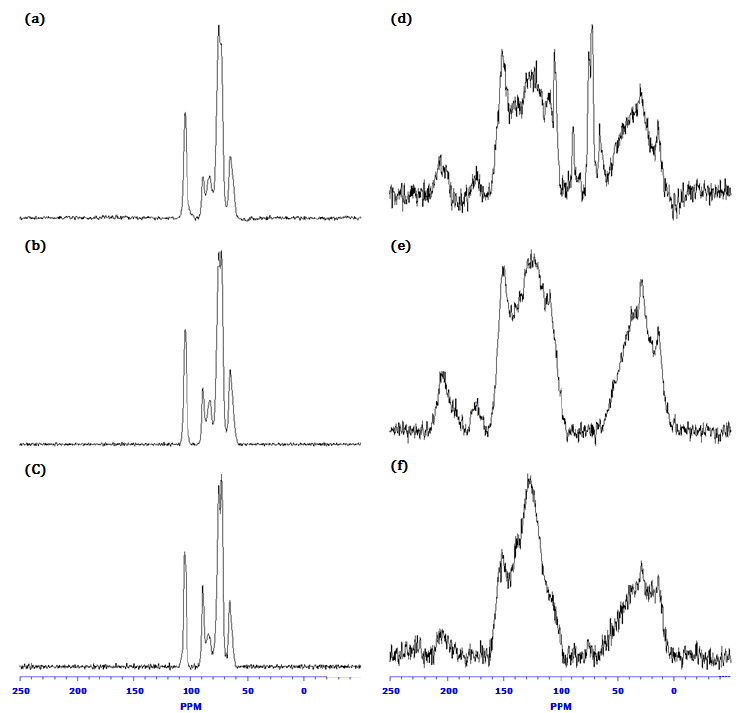
Figure 3. 13 C NMR spectra of cellulose ( a ) and their hydrothermal carbonization (HTC) biochar ( b – f ); ( a ) raw cellulose, ( b ) 180 °C, ( c ) 200 °C, ( d ) 220 °C, ( e ) 250 °C and ( f ) 280 °C.